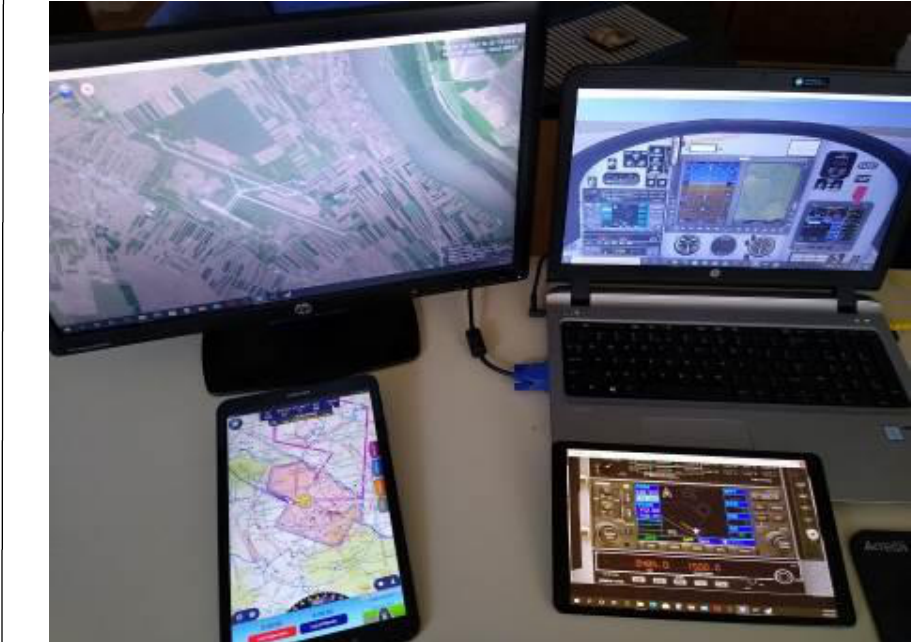
Figure 5 – Connection of the Sky Demon tablet with Microsoft Flight Simulators Рис. 5 – Подсоединение планшета с программой Sky Demon к